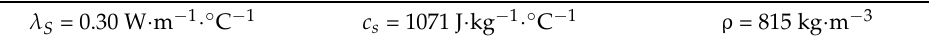
Table 3. Properties of gypsum